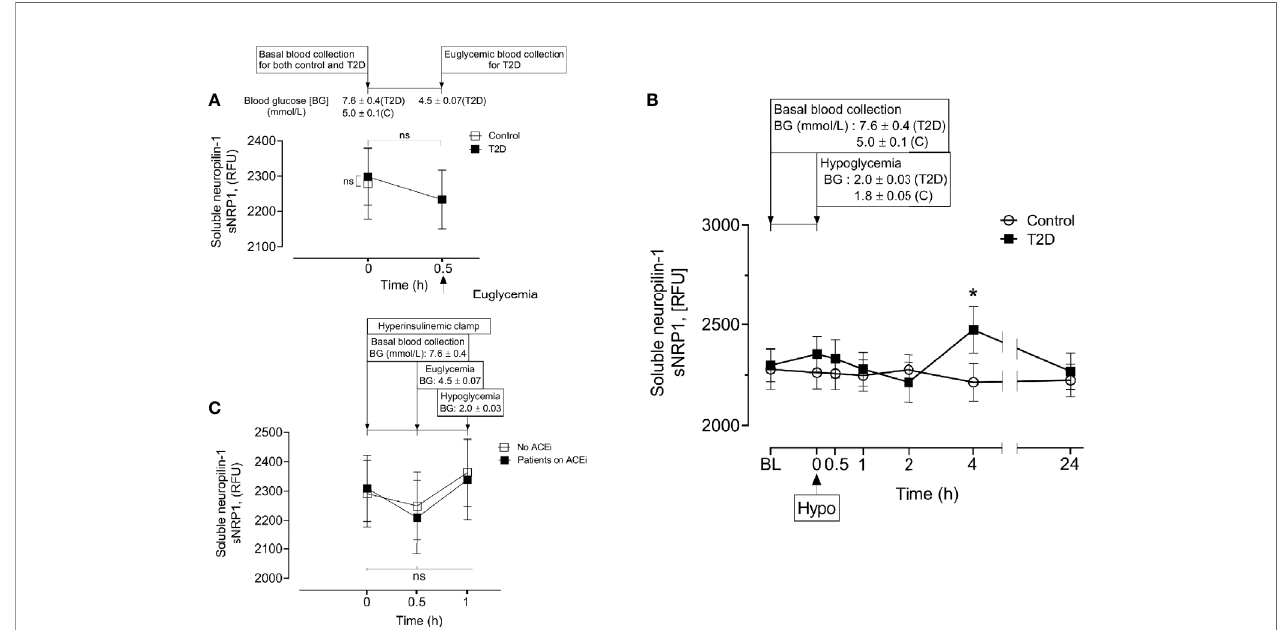
FIGURE 2 | Circulatory levels of Neuropilin-1 (soluble neuropilin-1, sNRP1) in plasma before, during and after iatrogenic induction of hypoglycemia. Blood sampling was performed at baseline (BL), euglycemia (30 min before hypoglycemia in type 2 diabetes (T2D) only), at hypoglycemia (0 min) and post-hypoglycemia (30 minutes, 1-hour, 2-hours, 4-hours and 24-hours). At baseline (BL), blood glucose (BG) was 7.6 ± 0.4 mmol/L (for T2D) and 5.0 ± 0.1 mmol/L (for control, C ). At glucose normalization, BG was 4.5 ± 0.07 mmol/L (for T2D). At the point of hypoglycemia, BG was 2.0 ± 0.03 mmol/L (for T2D) and 1.8 ± 0.05 mmol/L (for control). (A) Effect of glucose normalization on plasma sNRP1 levels in T2D (black squares) and control (open squares) subjects. (B) , Changes in sNRP1 levels in response to hypoglycaemia and post-hypoglycemic timepoints in control (white circles) and in T2D (black squares) subjects. (C) , Effect of glucose normalization and hypoglycaemia on plasma levels of sNRP1 in T2D patients who were treated with ACE inhibitors (ACEi) (black squares) and those without ACEi therapy (white squares). *p < 0.05, T2D vs control; Hypo, hypoglycaemia; RFU, relative fl uorescent units; ns, not signi fi